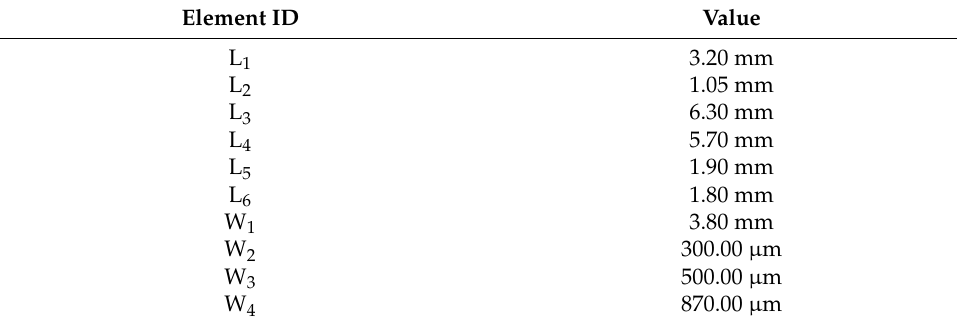
Figure 1. (a) Layout and (b) picture of the antenna array. Figure 1. ( a ) Layout and ( b ) picture of the antenna array. Table 1. Patch array geometrical Table 1. Patch array geometrical parameters.